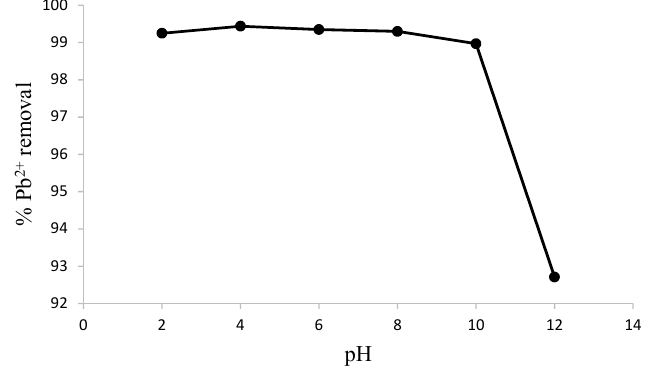
Figure 4. Variation of percent Pb 2+ removal with adsorbent dosage (initial concentration = 10.7 mg/L, contact time = 40 min, T = 298 K, pH = 4, shaking speed = 250 rpm).